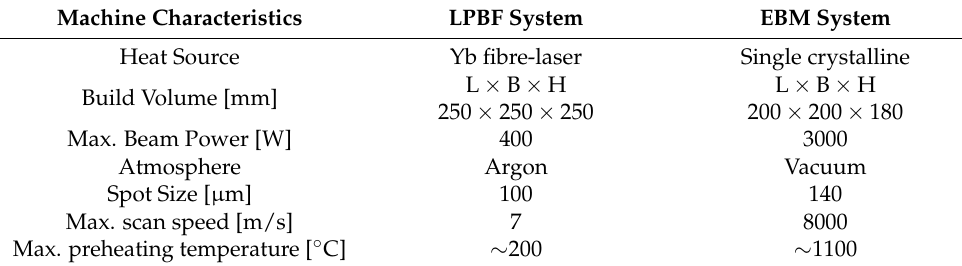
Table 1. Machine characteristics of the LPBF system and the EBM system.